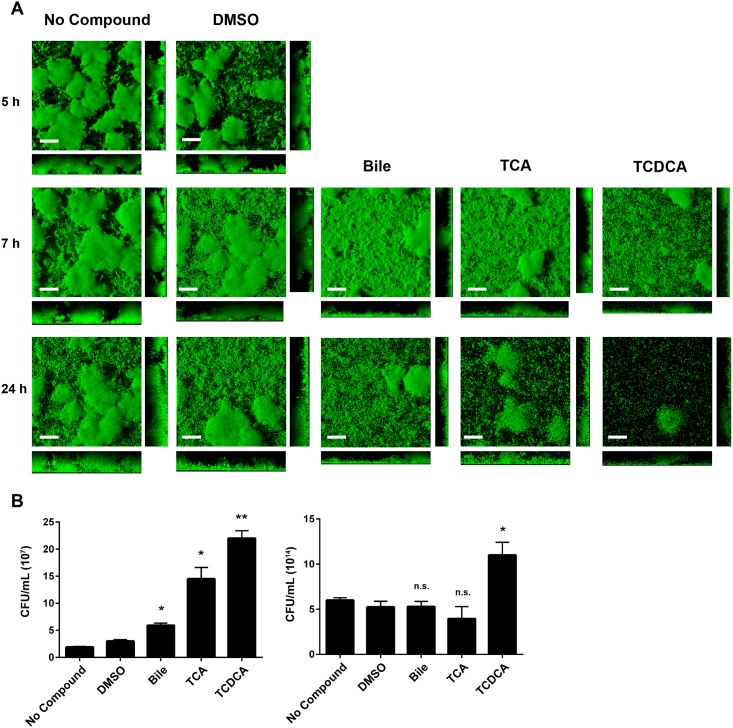
Bile acid components induce detachment of V. cholerae biofilms.(A) CSLM images of horizontal (xy) and vertical (xz and yz) projections of biofilm structures formed by the wild-type strain (wt). Biofilms were formed at 30°C for 5 hours. These biofilms were either untreated or exposed to DMSO, 0.4% Ox bile, 150 μM of TCA or TCDCA. CSLM images of biofilms were taken at 5, 7, and 24 hours. (B) Detachment from biofilms was evaluated by quantification of the planktonic population. CFU/mL of cells released from biofilms to the planktonic population was quantified for each condition at 7 h (left) and 24 h (right). Error bars indicate standard deviations of three biological replicates. *P < 0.05, **P < 0.005, n.s., P > 0.05.